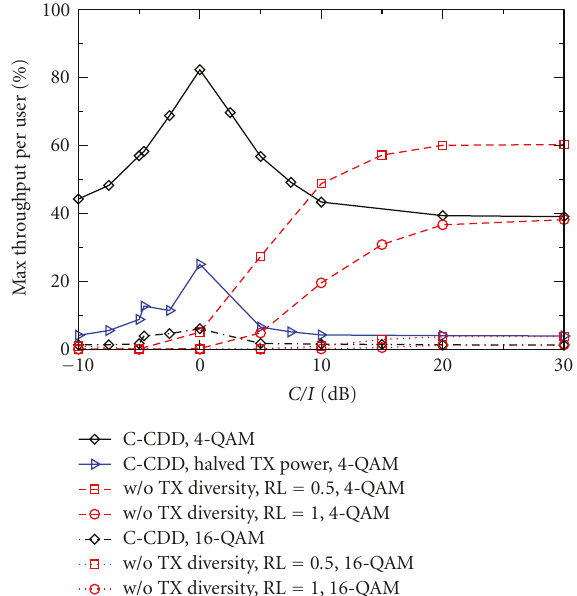
Figure 11: BER versus C/I for an SNR of 5dB using no transmit diversity and CAT for di ff erent scenarios.